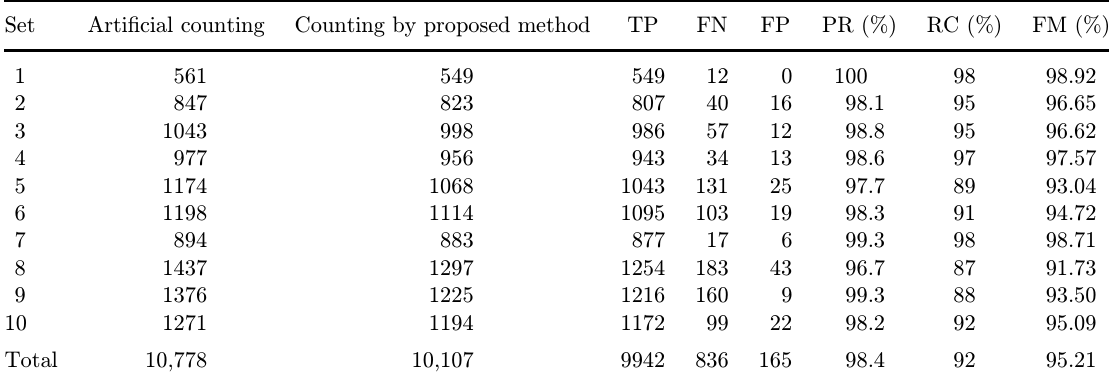
Table 1. Experimental results of the